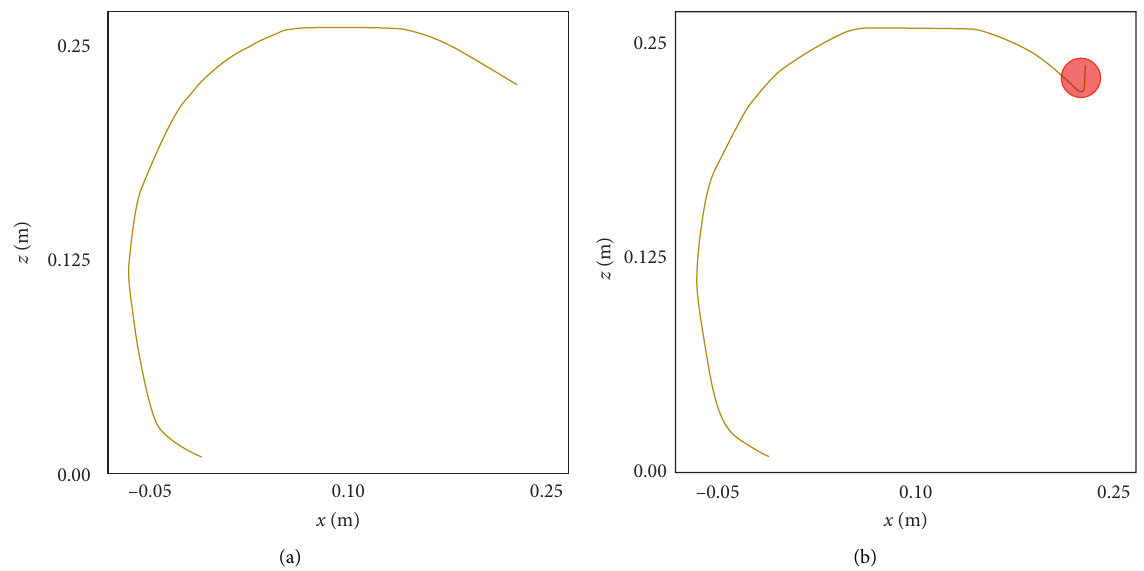
Figure 12: The first-step ankle joint planning of DMP gait movement. (a) Original plan; (b) foot coupling pressure.